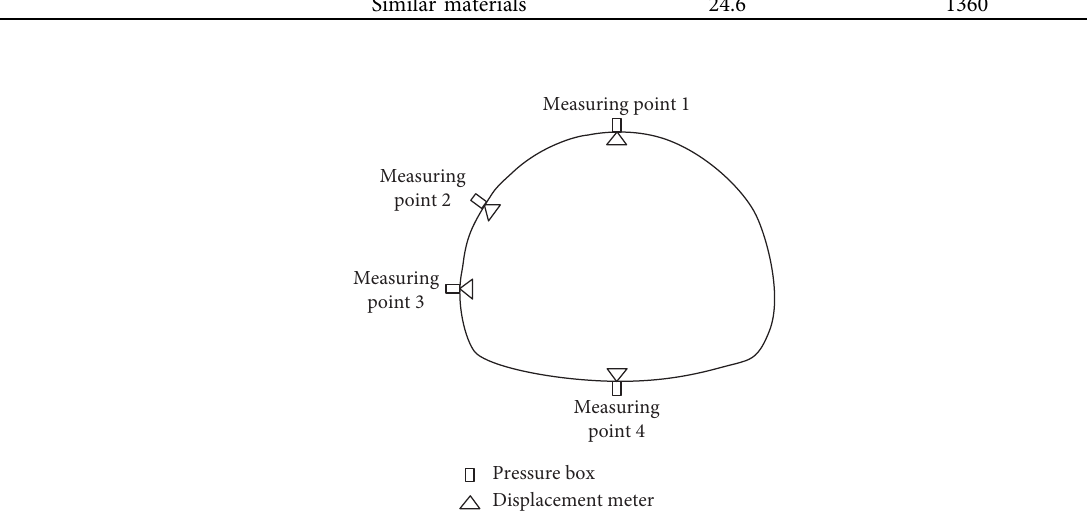
Figure 7: Arrangement of measuring